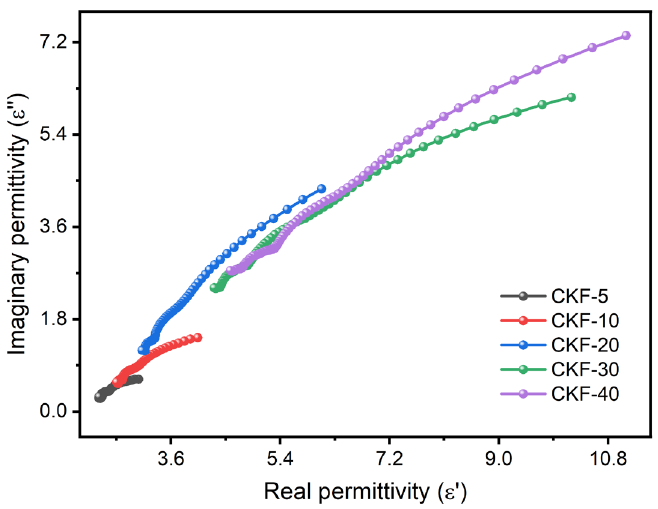
Figure 7. Cole–Cole curves of CKF-filled paraffin composites with different filler loading.